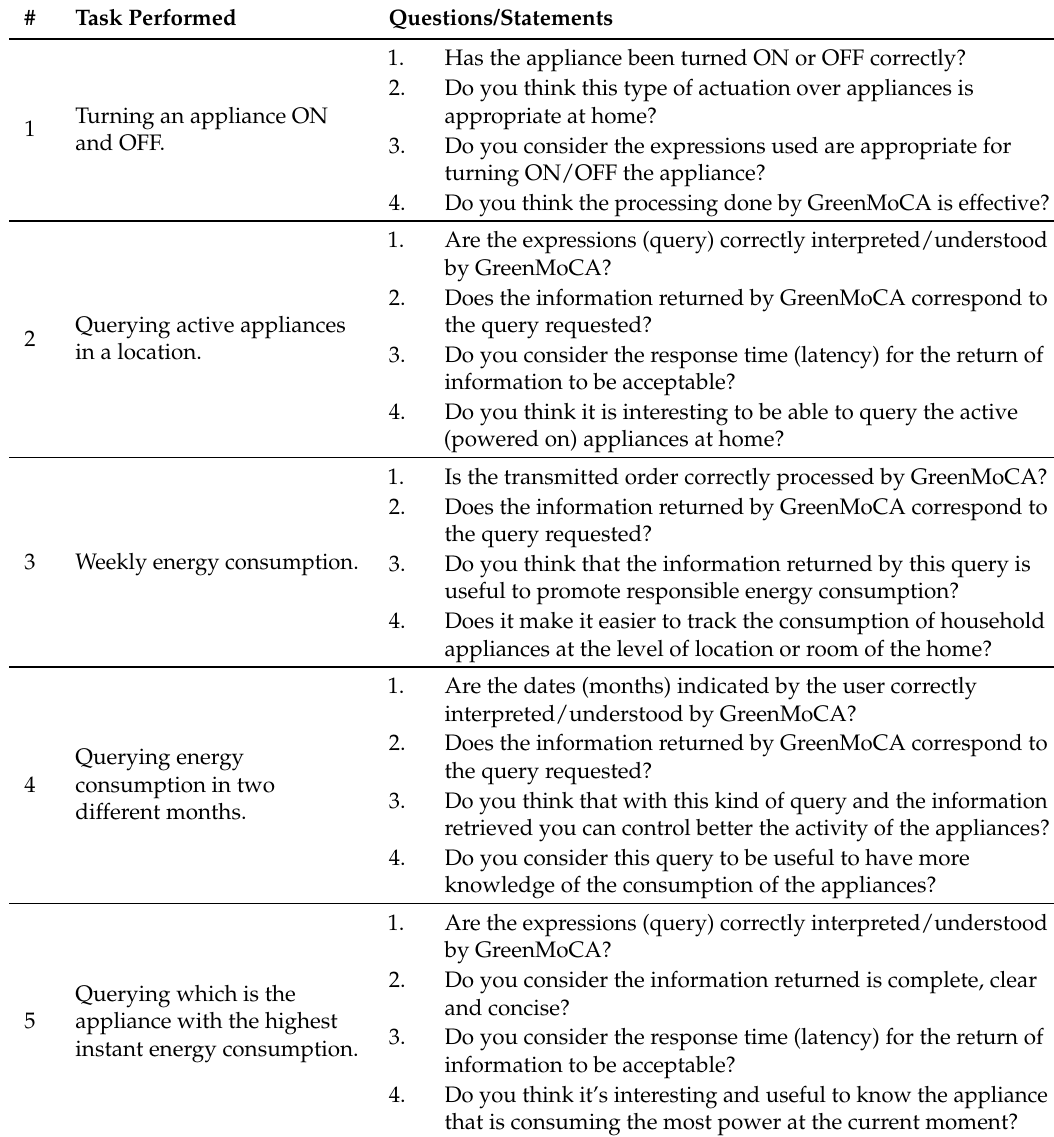
Table 2. Questions/statements to be answered by the users for each representative